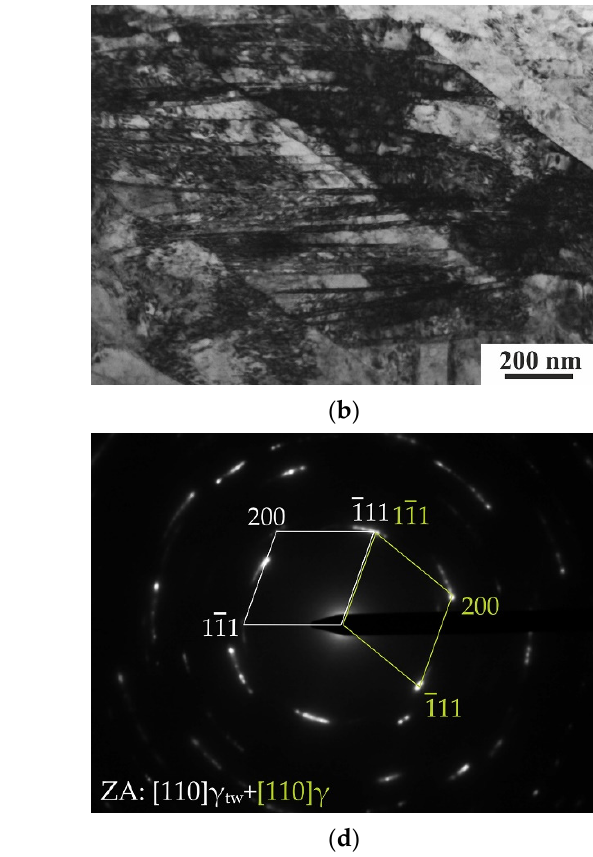
Figure 7. TEM images of steel microstructure after HTMT-3 in the section perpendicular to TD. BF image with fragmented plates ( a ), SAED patterns with marked two [110] γ zone axes ( b ).